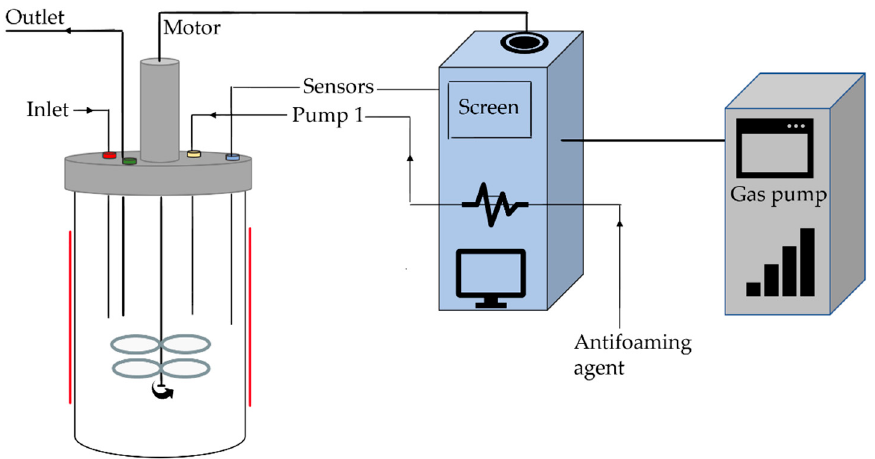
Figure 7. Lab-scale experimental set-up (7 L).